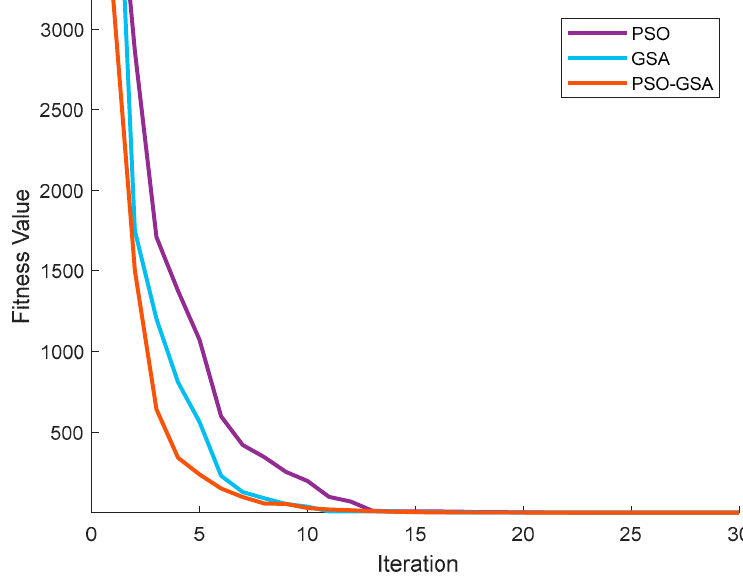
Figure 18. Algorithm convergence with Sphere objective function.